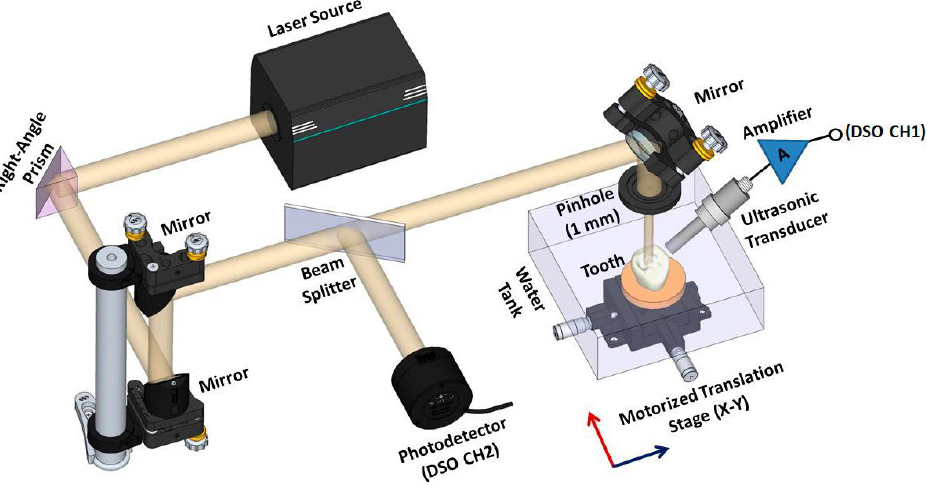
Figure 14. Simple diagram of photoacoustic imaging system. Adapted with permission from Ref. [157] 2022, PMC.